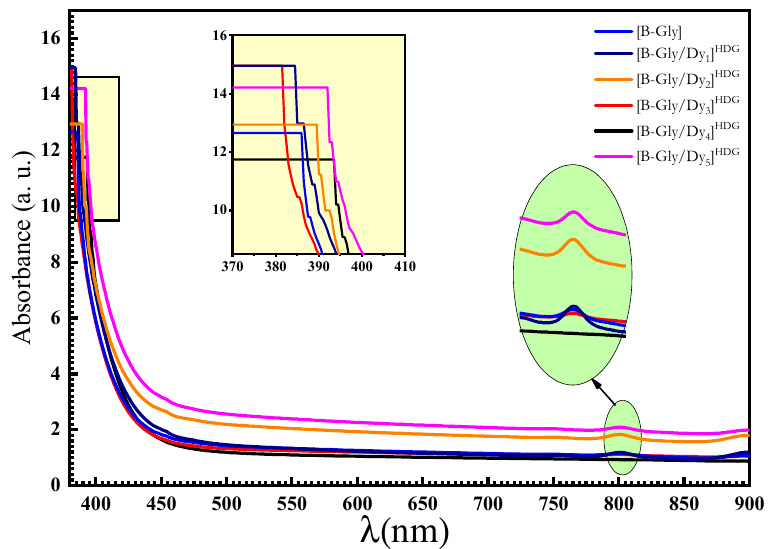
Figure 3. UV–Vis absorption spectrum of the prepared glass samples; the inset figure shows the optical band gap as a function of Dy 2 O 3 content.